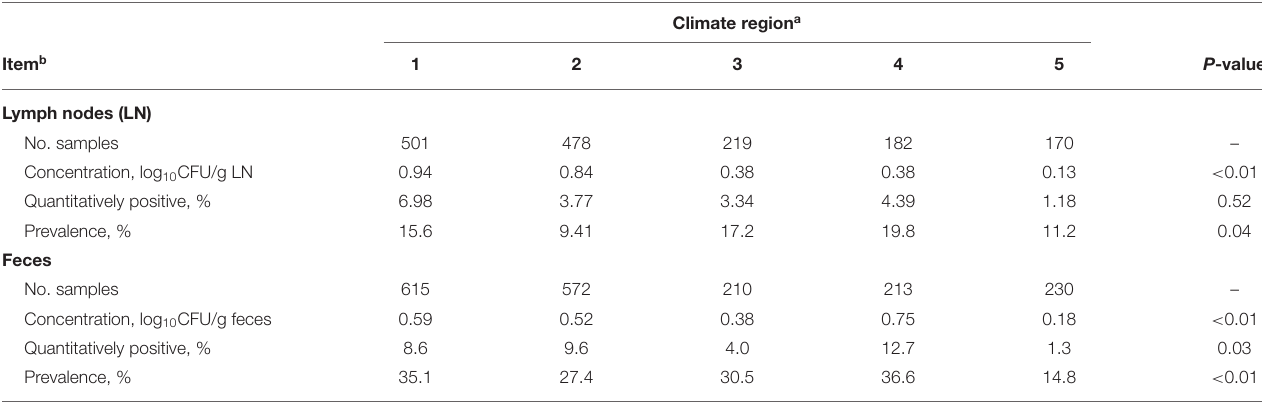
TABLE 3 | Prevalence of Salmonella in subiliac lymph nodes and feces in cattle at harvest by climate